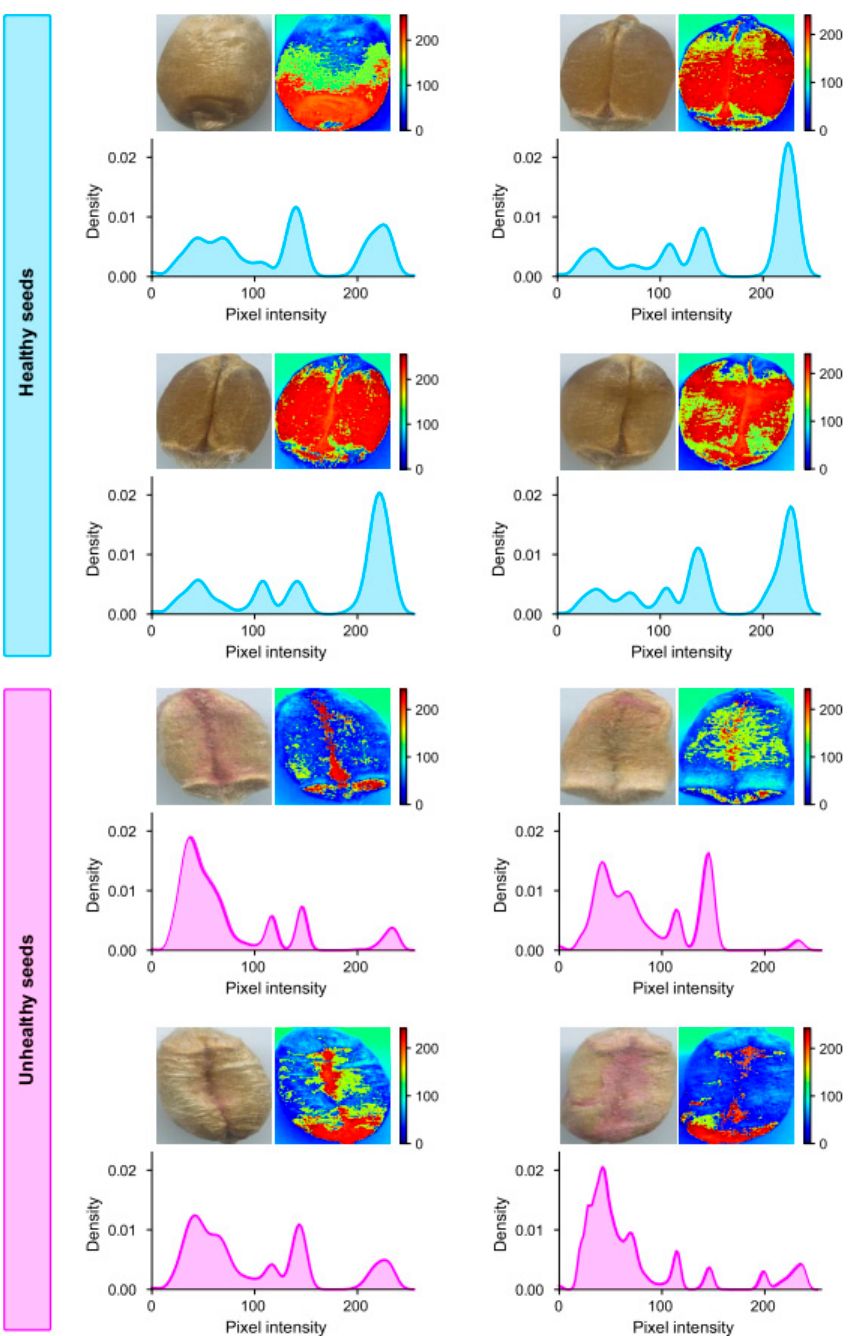
Figure 6. RGB images of healthy wheat seeds and seeds infected by Fusarium head blight disease show how the network activates different characteristics in the seed images to predict the presence of infected seeds. The RGB images are exhibited with their respective activation maps and histograms. In the activation map, the color range represents gray levels (0–255) of each pixel, wherein blue indicates regions with little activation, green and yellow indicate intermediate activation, and red indicates high feature activation.